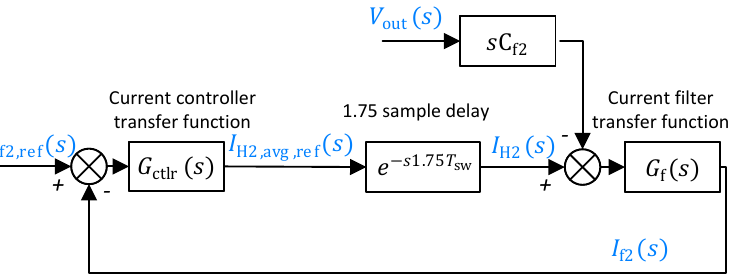
Figure 5. Schematic of the continuous-time equivalent model for the current control loop in s